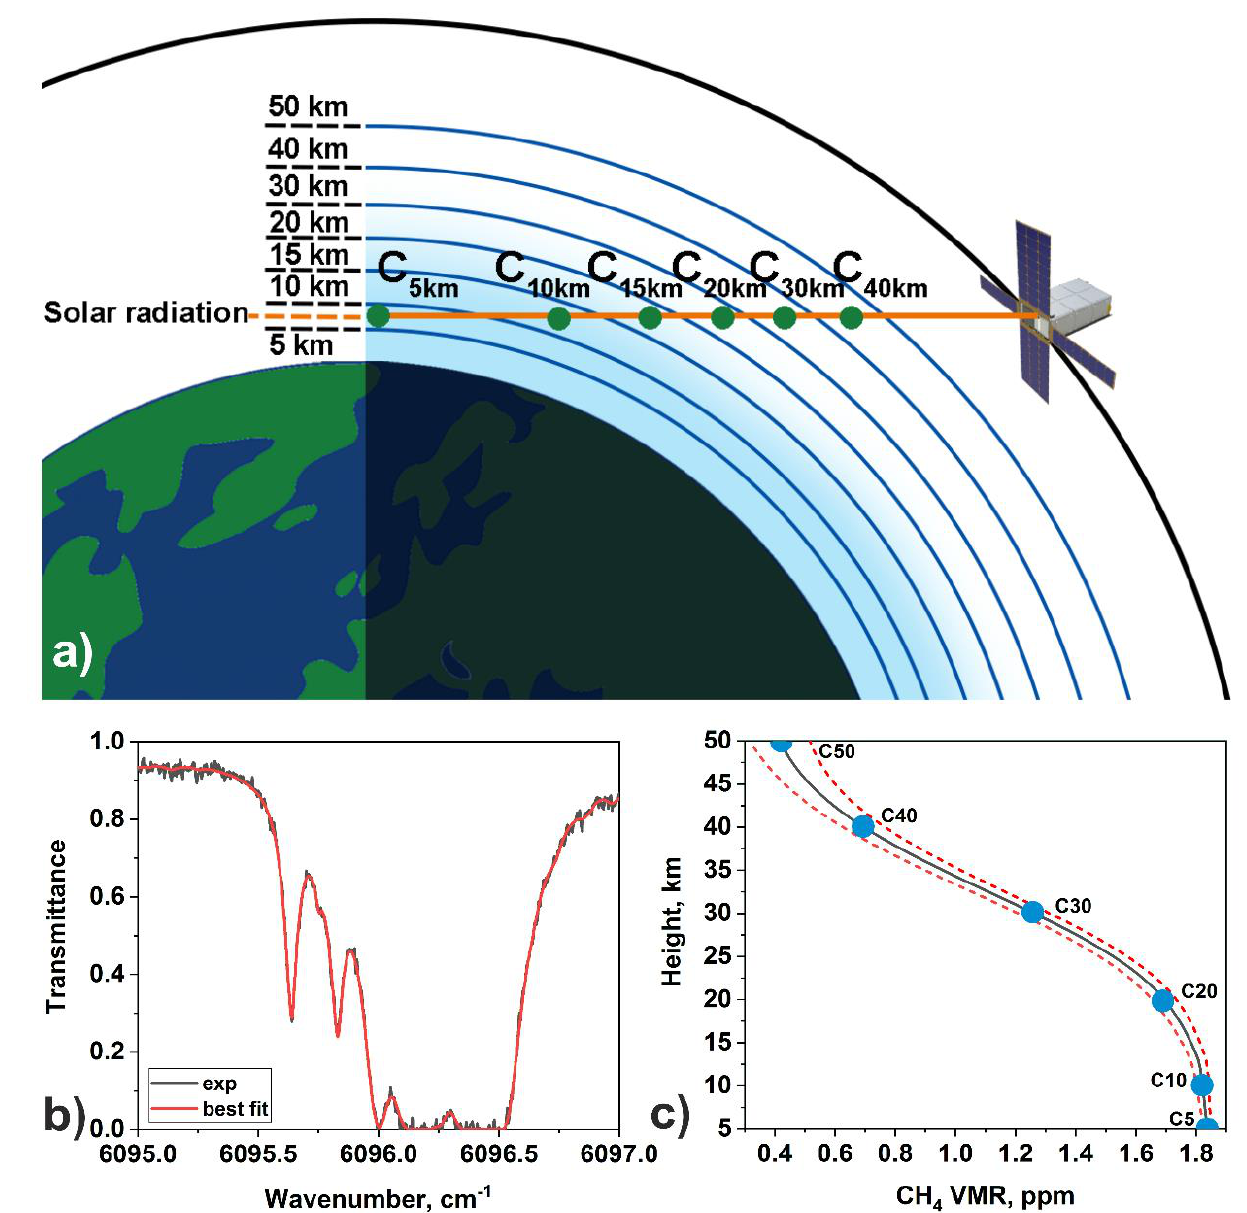
Figure 15. ( a ) Illustration of cross-influence of atmospheric layers located at different altitudes and different positions over the globe on the resulting measurement in the solar occultation mode. This a geometry of measurements to the building up a tomographic picture of sounded gas distribution. Green dots C5 km–C40 km correspond to blue dots C5–C40 on the profile of ( c ). ( b ) Synthetic atmospheric transmittance spectra (black curve) at 1640 nm with SNR of 50 at the tangent height of 5 km. The red curve is the model best-fit spectra used for inverse problem solution and lateral atmosphere structure analysis along the line of sight. ( c ) Distribution profile of CH4 concentration retrieved along the line of sight (black curve). Red curves are error identification. Blue points C5–C50 in ( c ) corresponds to the green points C5 km–C50 km illustrated in ( a ). Do not confuse the CH 4 profile illustrated in ( c ) with the standard vertical GHG profiles, which could be measured during sunrises/sunsets at solar occultation